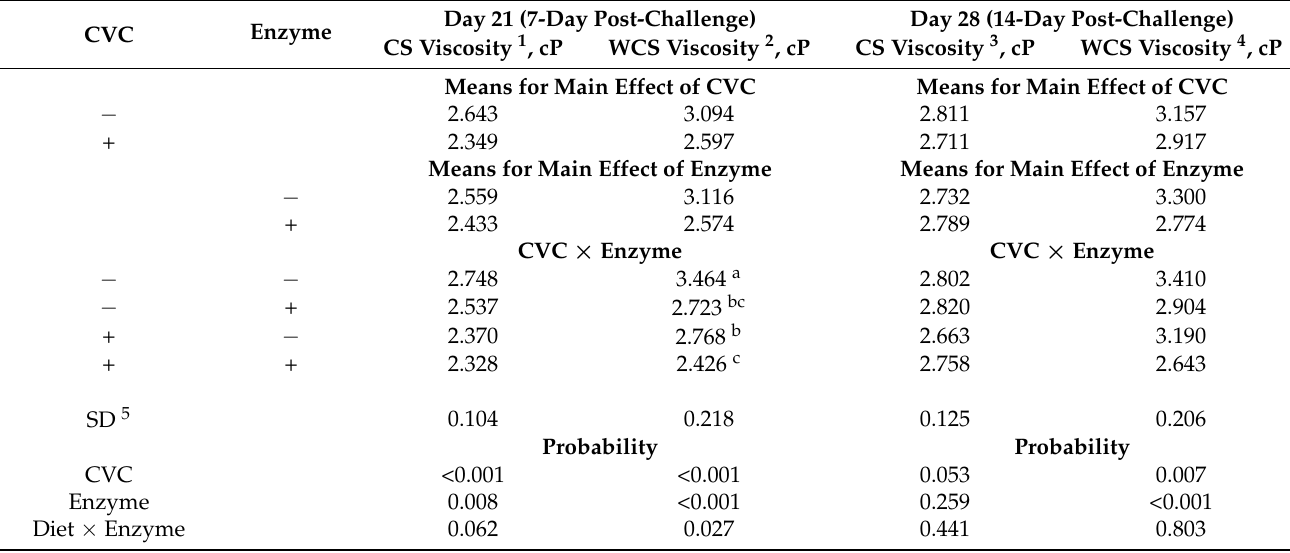
Table 8. Main and simple effects of coccidia vaccine challenge (CVC) and exogenous enzyme supplementation on jejunal viscosity (cP) in 21- (7-day post-challenge) and 28- (14-day post-challenge) day-old broiler chickens fed corn-soybean (CS)- or wheat-corn-soybean meal (WCS)-based diets.